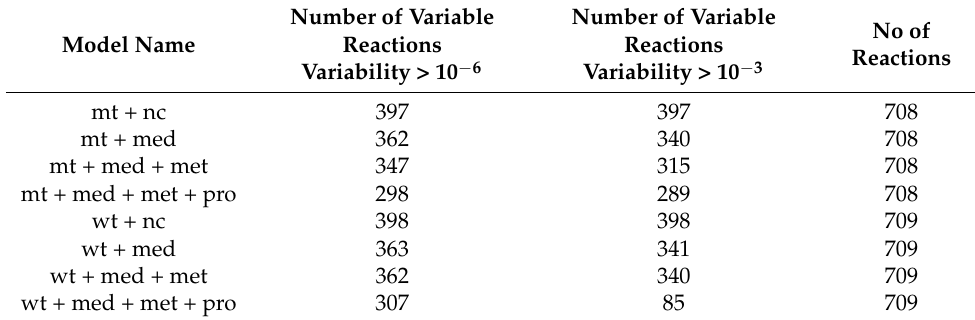
Table 1. Number of variable reactions in differently constrained genome-scale models of E. faecalis wildtype (wt) and ∆ glnA mutant (mt). Here, “nc” indicates model version without any constraints, “med” indicates integration of medium composition, “met” the additional integration of data on metabolite uptake and release and “pro” the additional integration of proteome